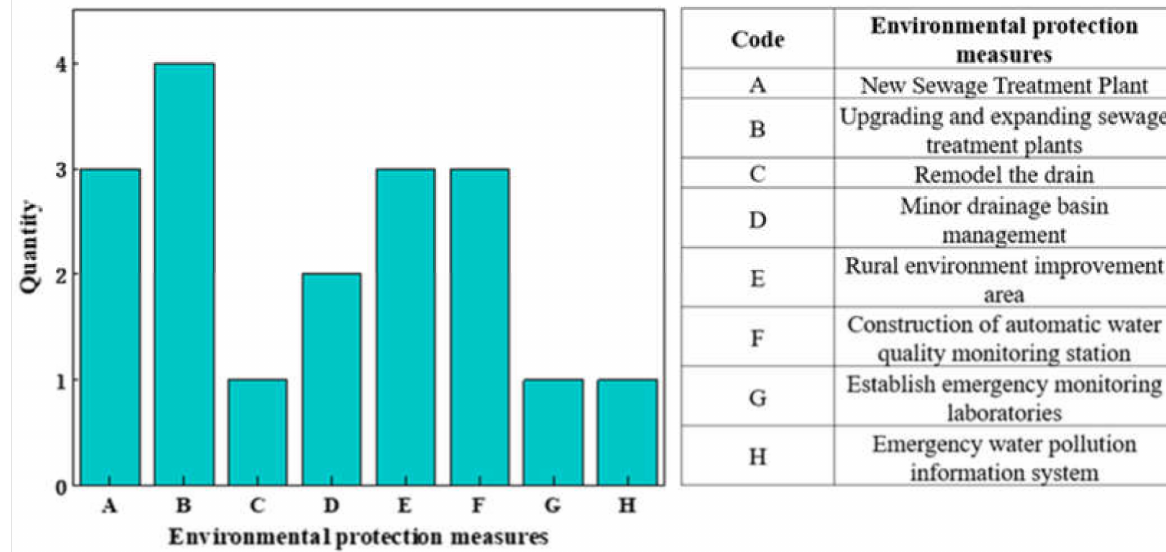
Figure 12. Optimization and adjustment measures for water environmental protection. (A–H) Code of optimization measures. Code notes are shown in the table on the right